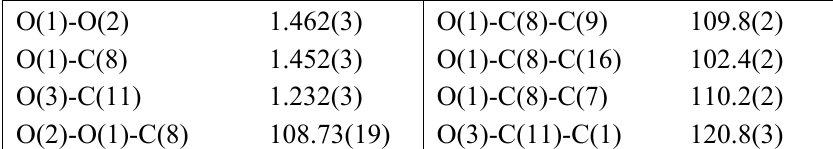
Table 1. Selected bond lengths (Å) and angles (°) for 3 (e.s.d.s in parentheses).